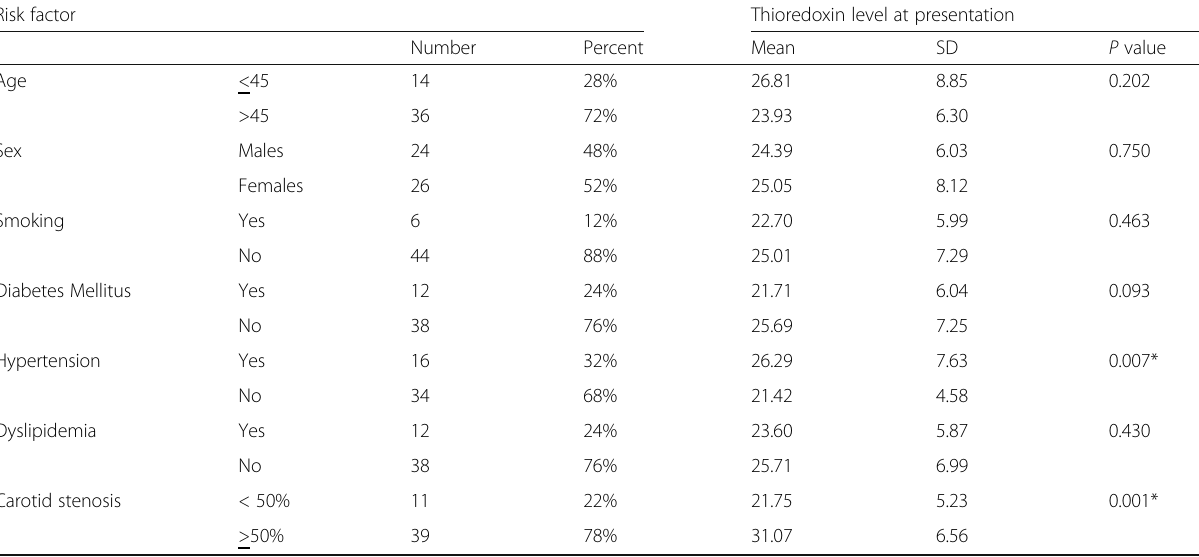
Table 3 Relation between risk factors of stroke and thioredoxin level at presentation in 50 acute stroke patients Risk